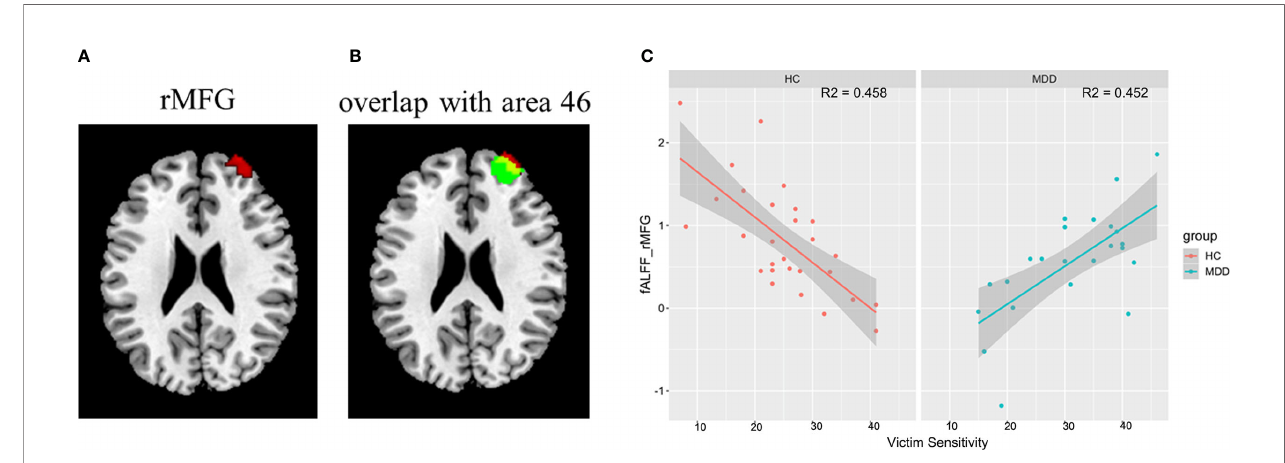
FIGURE 1 | Interaction effect between diagnosis and victim sensitivity on fALFF and the results of post hoc analysis. (A) The region showing signi fi cant interaction effect between diagnosis and victim sensitivity; (B) The region showing signi fi cant interaction effect was overlaid with the area 46 in the Brainnetome Atlas Reviewer (http://atlas.brainnetome.org/). (C) Scatter plots for the relationship between the fALFF value and victim sensitivity within each group with the shadow parts representing 95% con fi dence interval. Abbreviation: rMFG, right middle frontal